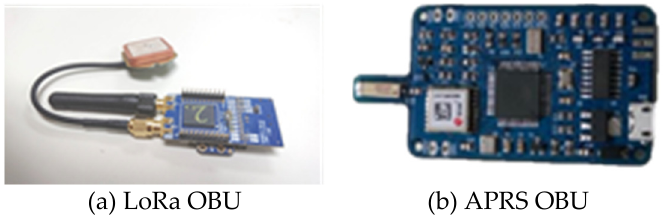
Figure 8. ADS-B like on-board unit (OBU), LoRa and APRS.